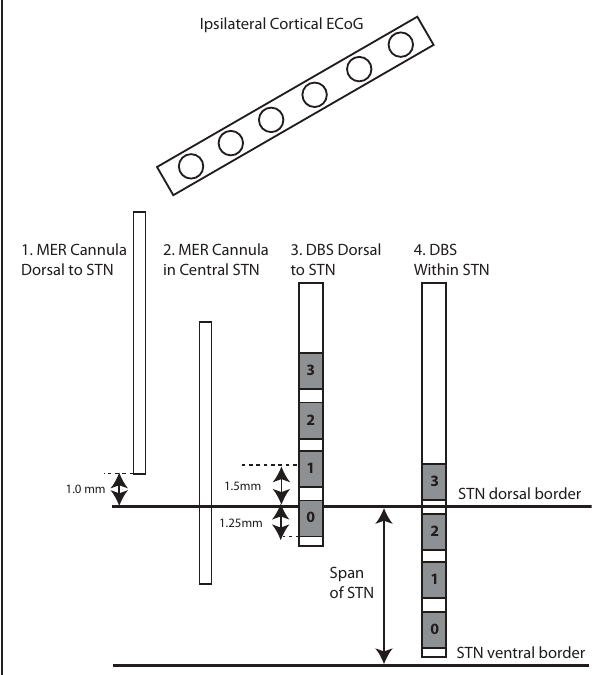
FIGURE 1 | Experimental design. In all cases ( n = 13), STN LFPs were recorded bilaterally between electrodes 0–2, before and during DBS stimulation through electrode 1, in each of the two positions. The first position places the center of electrode 1 at 1.5mM dorsal to the dorsal border of the STN, and the second position places the center of electrode 1 within the STN. In a subset of these cases ( n = 3), the 1mM distal tip of the cannula that ensheaths the microelectrode was used to record monopolar LFPs after functional mapping and before implantation of the DBS lead, in each of two positions: (1) 1mM dorsal to the dorsal border of the STN, and (2) at the midpoint of the dorsal and ventral borders of the STN. In these cases, the ECoG strip was placed over ipsilateral motor cortex during all STN recordings (cannula and DBS